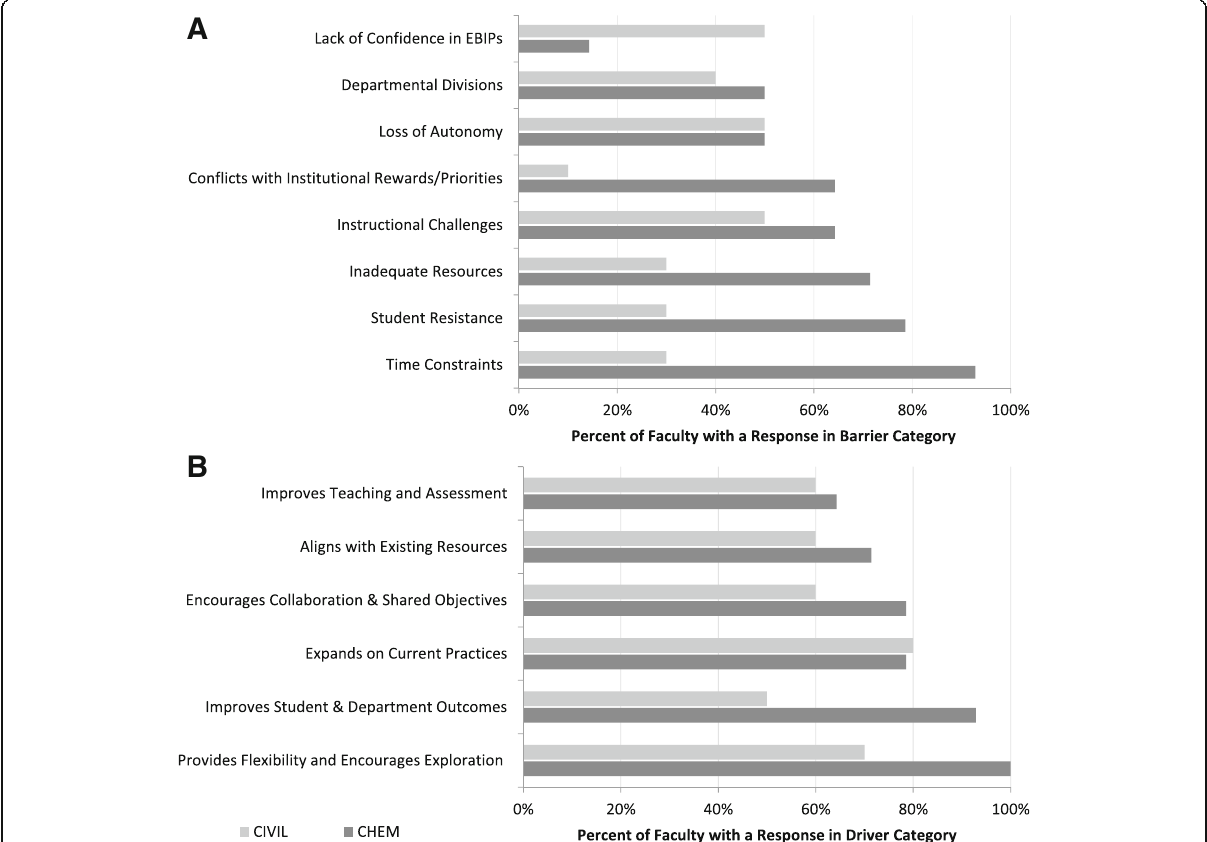
Fig. 2 Sample department comparison: barriers ( a ) and drivers ( b ) to STEM education reform. Categories were emergent based on analysis of comments aggregated across all STEM departments. The length of the bar indicates the percent of participants who had a response that was coded to the respective